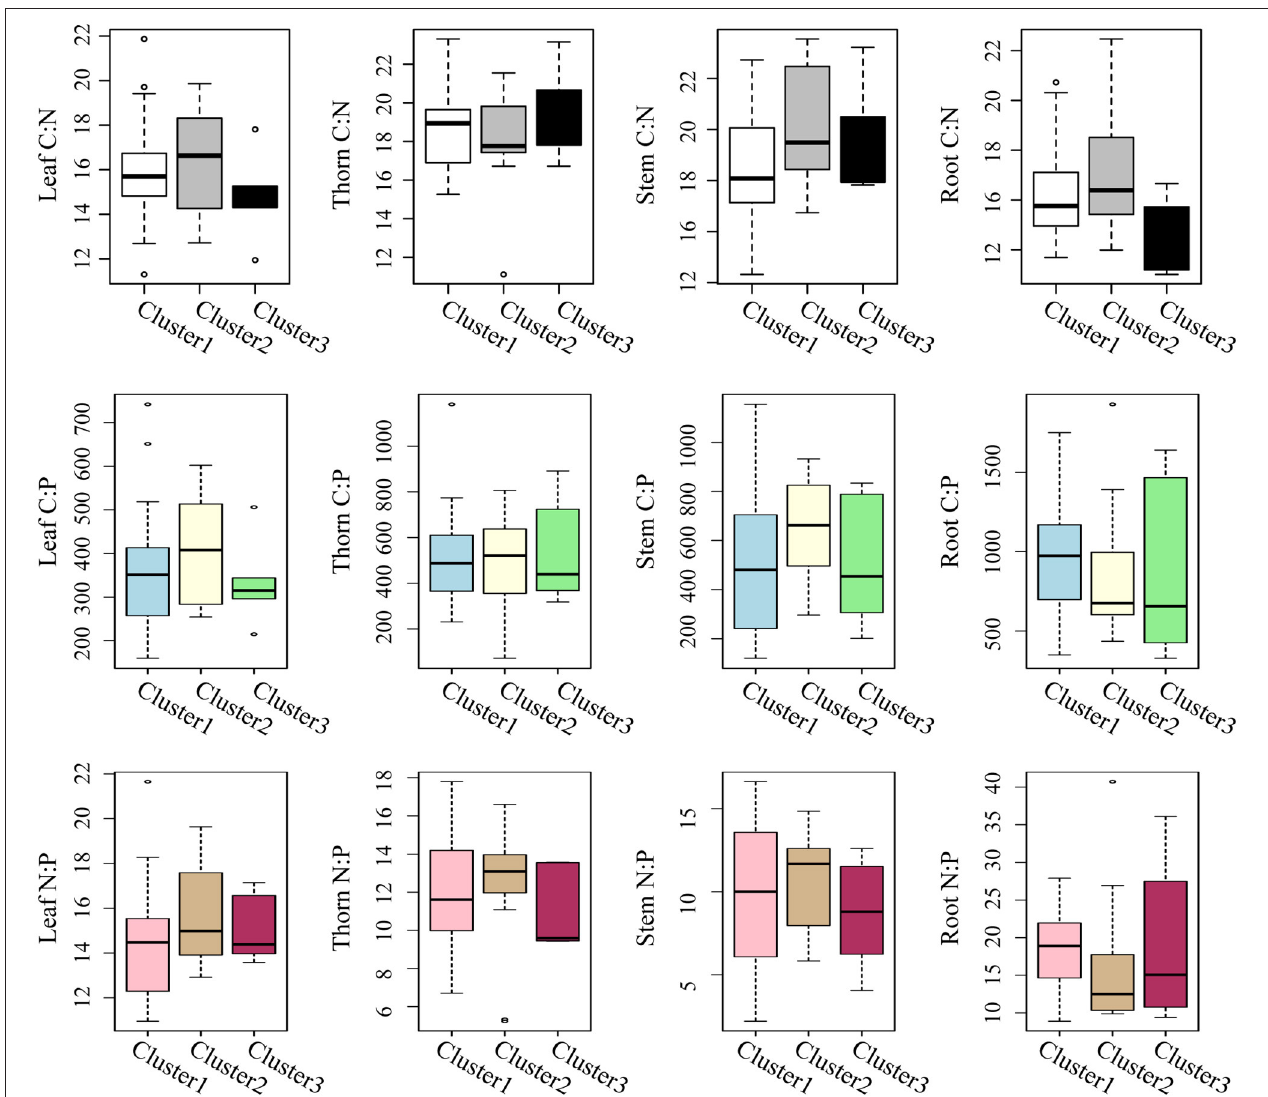
FIGURE 5 | Boxplots of the C:N, C:P, and N:P ratios in leaf, thorn, stem, and root organs of Alhagi sparsifolia for the three sampling site clusters that differed in mean annual precipitation and soil water